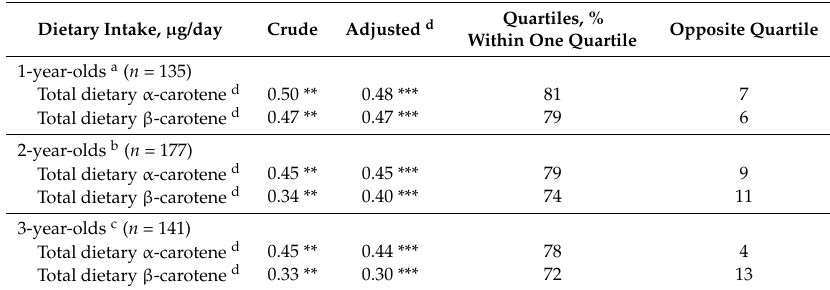
Table 4. Spearman and partial correlation coefficients (adjusted for energy intake, serum cholesterol and body mass index), and cross-classification averages of quartiles, estimated from the daily dietary intakes of α -and β -carotene, assessed with 3-day food records and the respective serum concentrations among 1-, 2-, and 3-year-old Finnish children. Quartiles, % Dietary Intake, µ g/day Crude Adjusted d Opposite Quartile Within One Quartile 1-year-olds a ( n = 135) Total dietary α -carotene d 0.50 ** 0.48 *** 81 7 Total dietary β -carotene d 0.47 ** 0.47 *** 79 6 2-year-olds b ( n = 177) Total dietary α -carotene d 0.45 ** 0.45 *** 79 9 Total dietary β -carotene d 0.34 ** 0.40 *** 74 11 3-year-olds c ( n = 141) Total dietary α -carotene d 0.45 ** 0.44 *** 78 4 Total dietary β -carotene d 0.33 ** 0.30